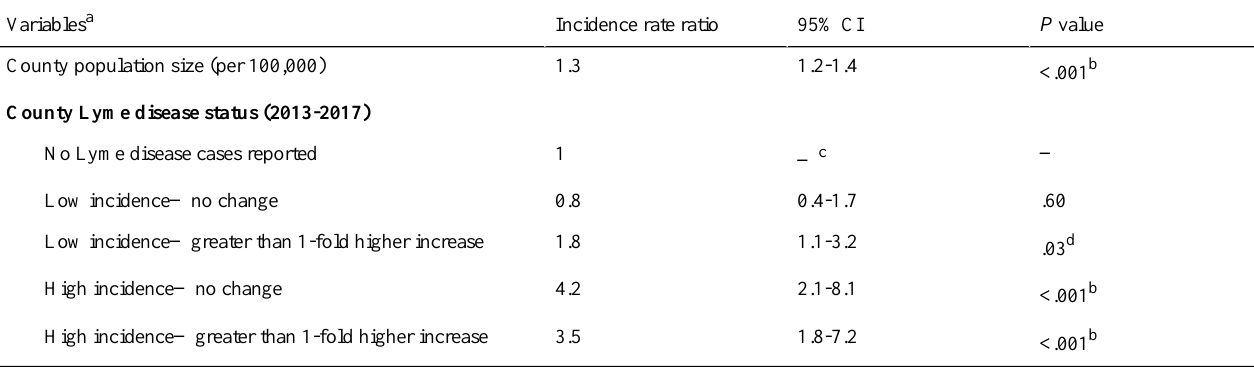
Table 3. Generalized linear mixed model for the number of users per county versus the county population size and the Lyme disease status of the county based on Lyme disease incidence and percent change of cases from 2013 to 2017, adjusting for the regions’random effects. We used a negative binomial model, and the effect of each independent variable is expressed as incidence rate